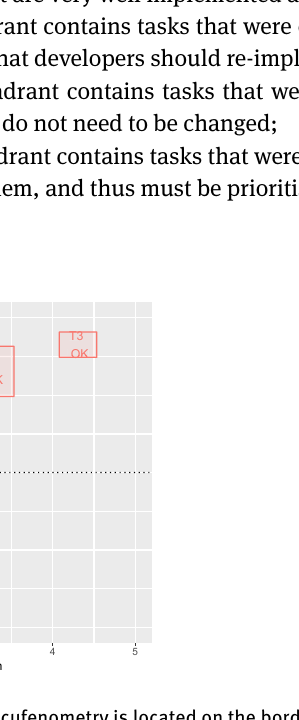
Figure 7: EM analysis, only acufenometry is located on the borderline